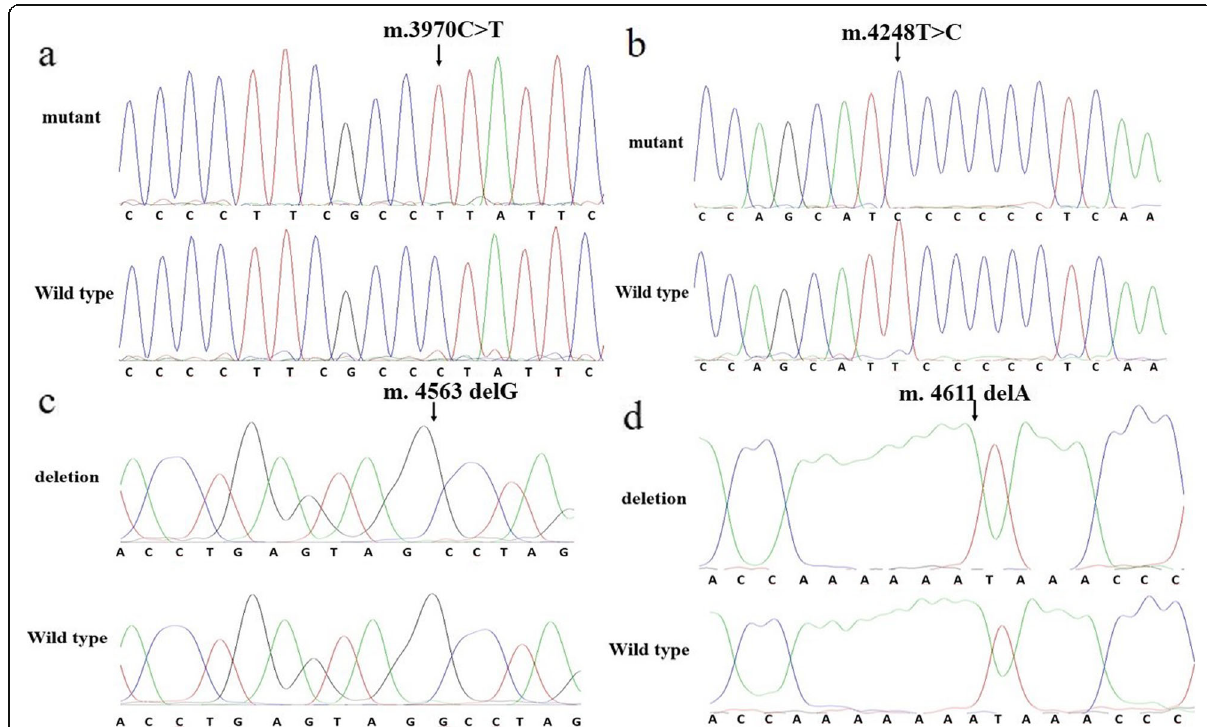
Fig. 2 a . Identification of the m.3970C > T mutation in the mitochondrial ND1 gene. Arrow indicates the position of the gene mutation. b . Identification of the m.4248 T > C mutation in the mitochondrial ND1 gene. Arrow indicates the position of the gene mutation. c . Identification of the m.4563 delG mutation. Arrow indicates the position of the deletion mutation. d . Identification of the m.4611delA mutations. Arrow indicates the position of the deletion